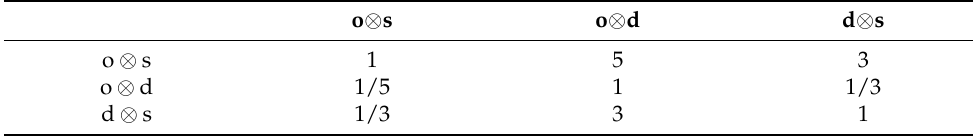
Table A7. Judgment matrix related to PRISM pattern elements.